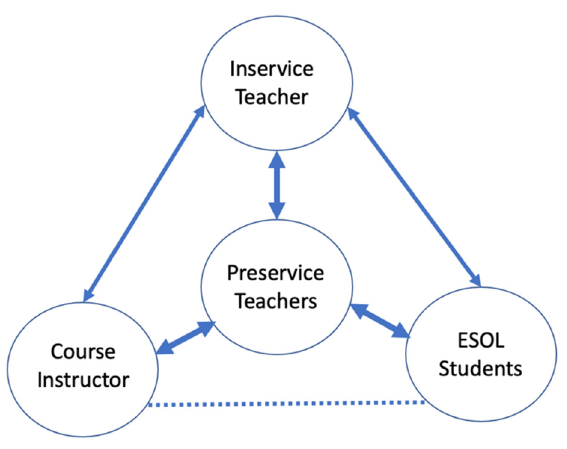
Figure 8. Reflection